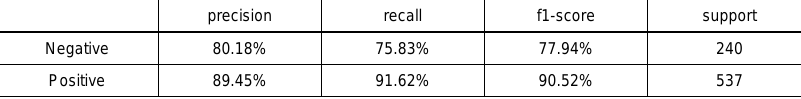
Table 2. Specific evaluation